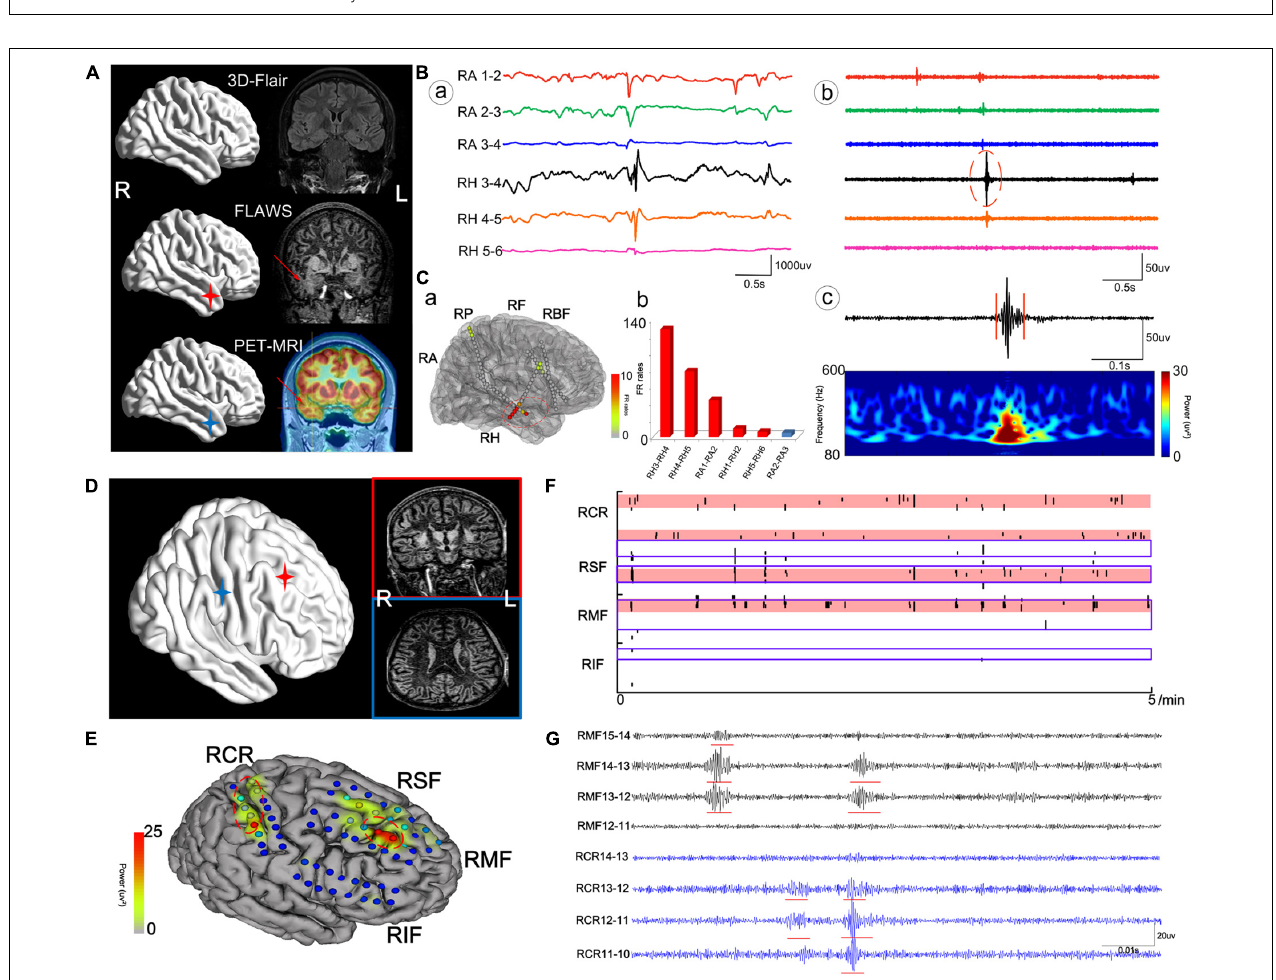
FIGURE 4 | The cases of patient #2 (A–C) and patient #11 (D–G) . (A) The neuroimaging results for patient #2. (B) Raw data (a) and intracranial electroencephalogram (iEEG) signal after the bandpass filtering (200–500 Hz) (b) of some meaningful channels. (c) One FR detected using our detector. RA, right amygdala; RH, right hippocampus. (C) Results of HFOs shown on the model of the brain of patient #2 (a) and the rank in a descending order according to FR rates (b). The red color marks the suspicious channels indicated by the HFO threshold. RP, right parietal lobe; RF, right frontal lobe; RBF, right basis of frontal lobe. (D) The neuroimaging results for patient #11. (E) The FR rates shown on the brain model. RCR, right central areas; RSF, right superior frontal lobe; RMF, right mesial frontal lobe; RIF, right inferior frontal lobe. (F) The timing of all FRs detected in each channel with our automatic detector during a 5-min iEEG segment. The time and location of each FR are presented as points. The resected area is delineated by the blue line. The pink regions show the EZ confirmed using our quantified threshold. One area marked by HFOs had not been damaged. (G) The detectable FRs in different channels. The red arrows indicate the marked abnormal areas.